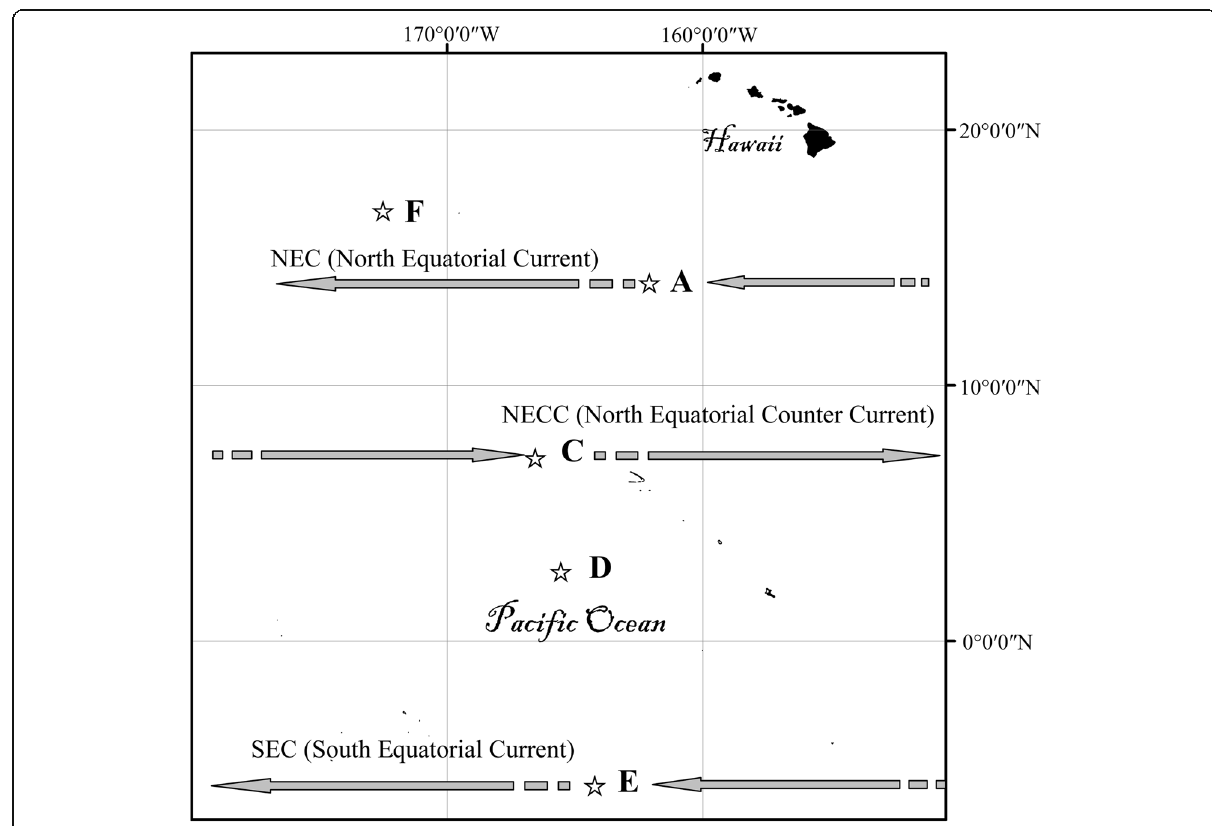
Fig. 1 Location of the 5 sampling sites in the Central Pacific